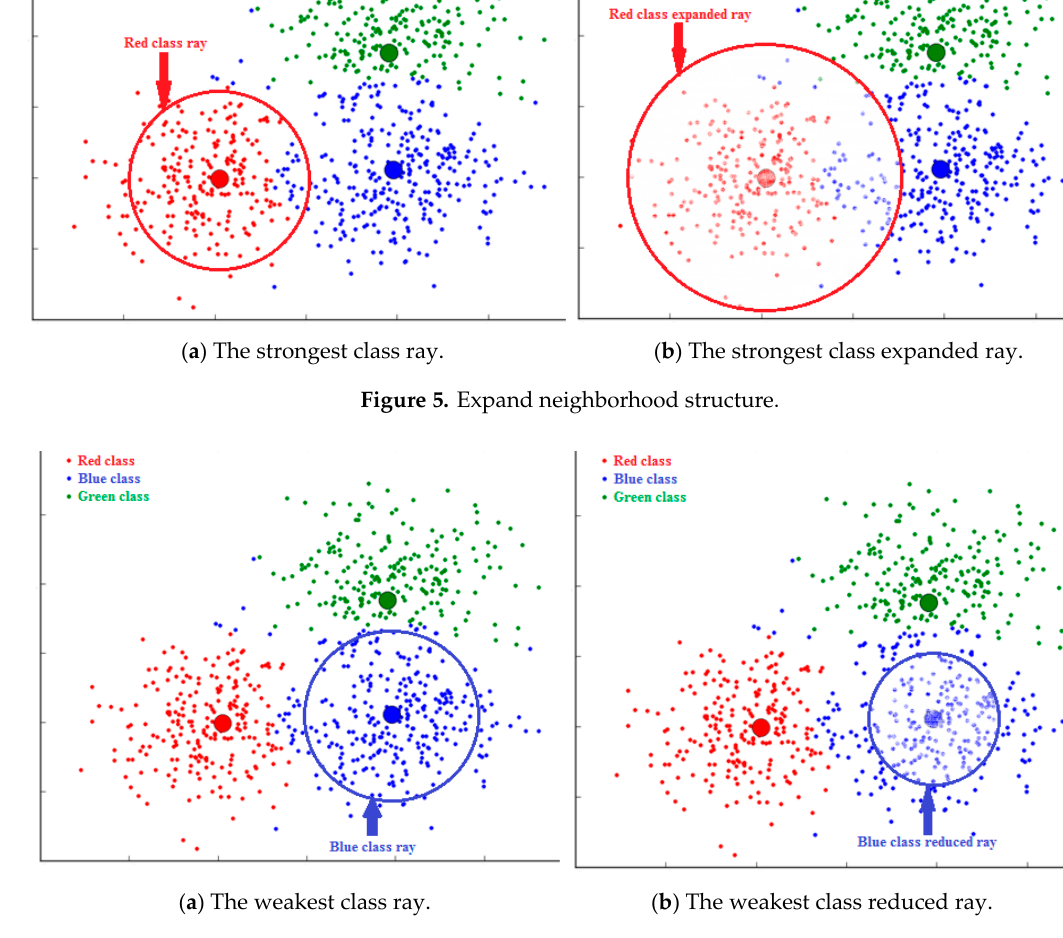
Figure 6. Reduce neighborhood structure.